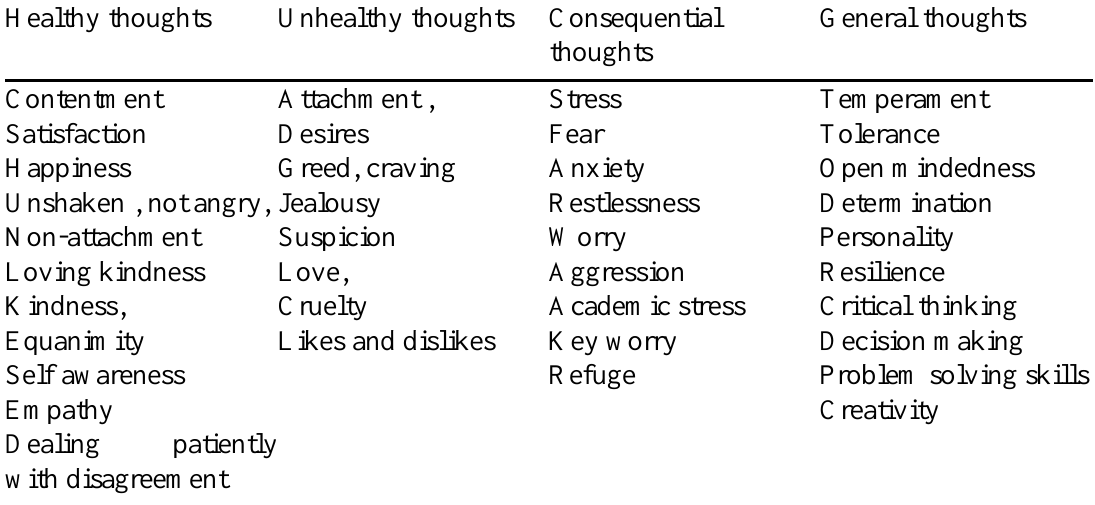
Figure 1. Classification of variables constituting health * Healthy thoughts Unhealthy thoughts Consequential